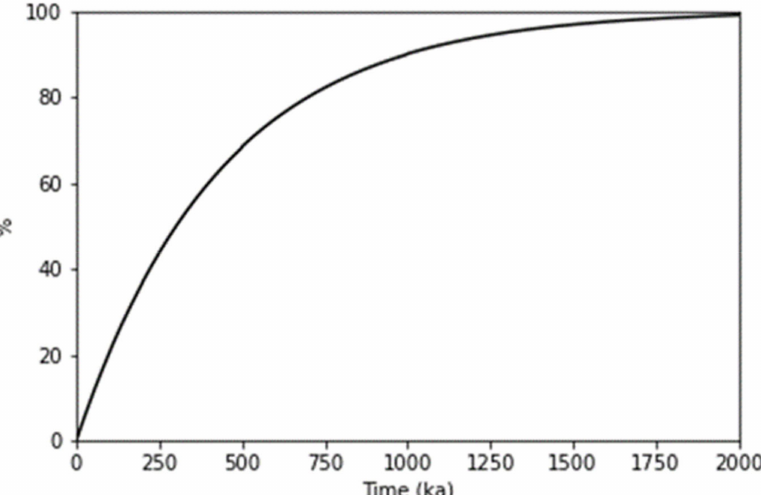
Figure 2. Modeled background production over time, shown as percent of the full equilibrium amount, based on Equation (1). Time to reach equilibrium is dependent on the half-life of 36 Cl. In this article, we present 89 cosmogenic 36 Cl exposure ages, sampled from both glacial and volcanic landforms, all adjusted for the young rock formation ages. In addition, we present the results of the geochemical analyses for each sample, thereby adding to the previously available geochemical data from Jan Mayen